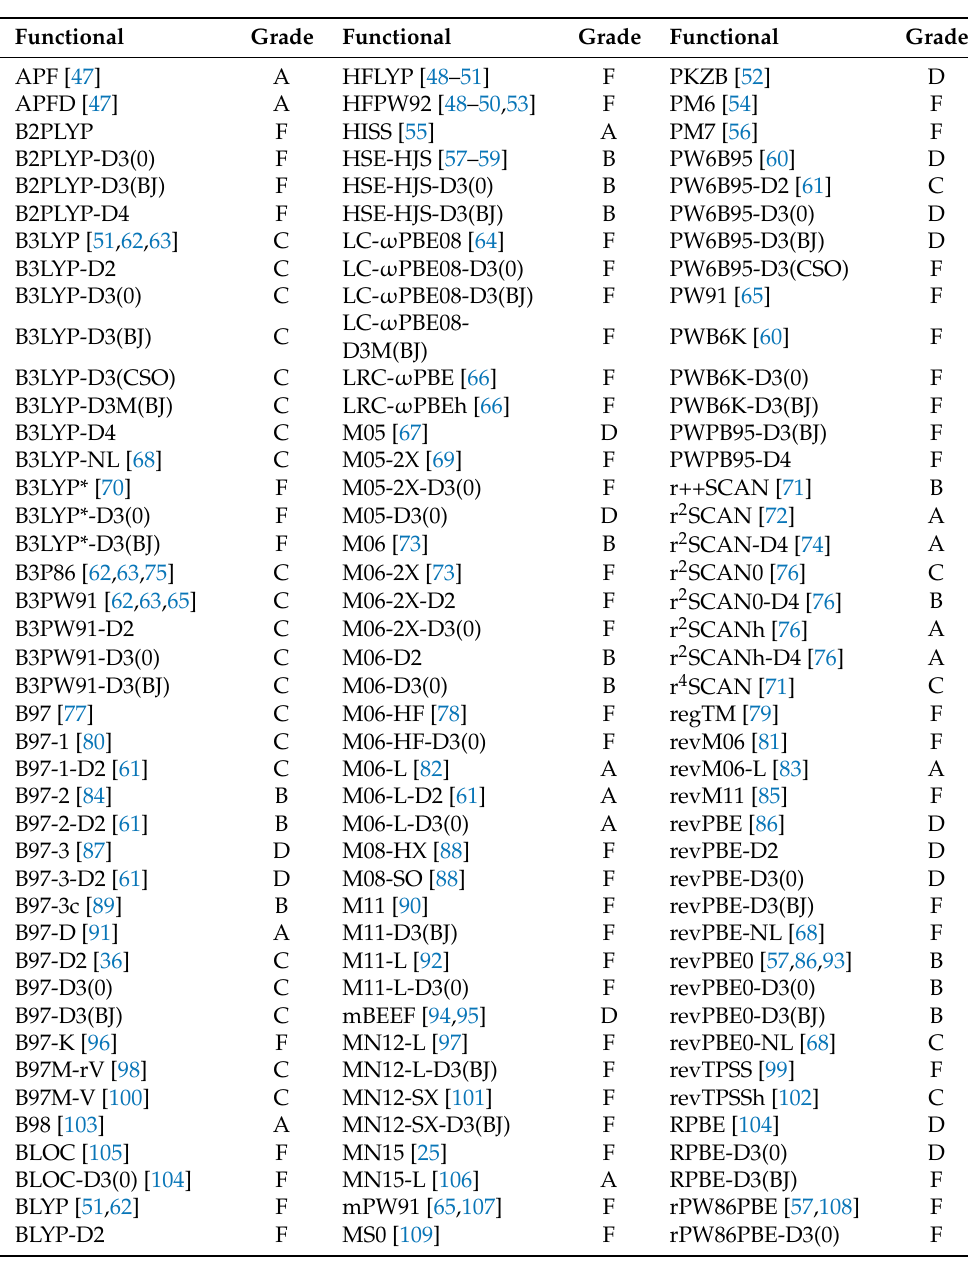
Table 1. List of methods examined in this study and their overall grade based on the MUE for Por21. Functionals are listed in alphabetical order, and grades are assigned based on percentile ranking, corresponding to the following thresholds: A: MUE < 14.3 kcal/mol; B: MUE < 17.1 kcal/mol; C: MUE < 20.0 kcal/mol; D: MUE < 23.0 kcal/mol; F: MUE > 23.0 kcal/mol. The dispersion corrections are covered in [24,36–46], unless noted otherwise. The MUEs were calculated from the CASPT2 reference energies; see the ‘Material and Methods’ section for further details. See also the Supporting Information for results on the PorSS11 and PorBE10